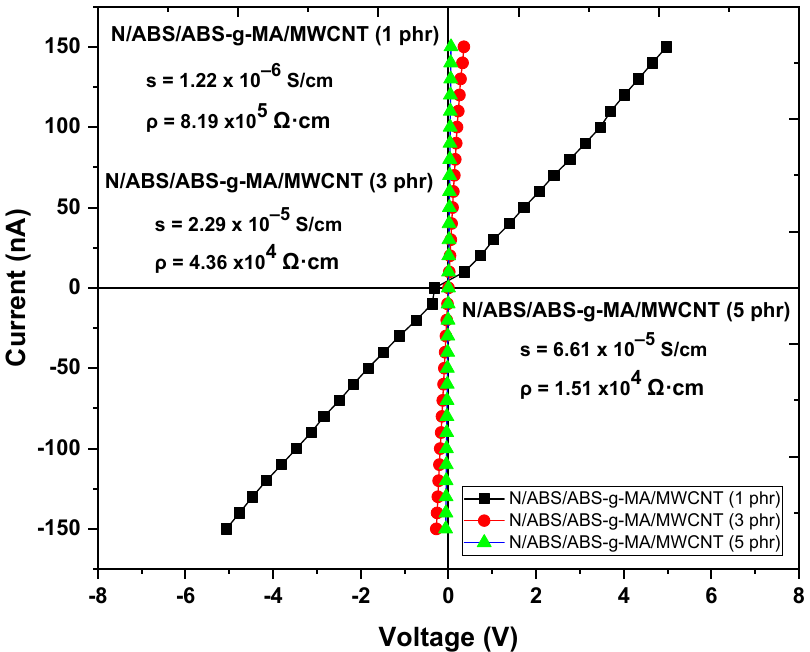
Figure 3. Electrical behavior of the nanocomposites in the –7 V to 7 V range. N = Nylon 6.